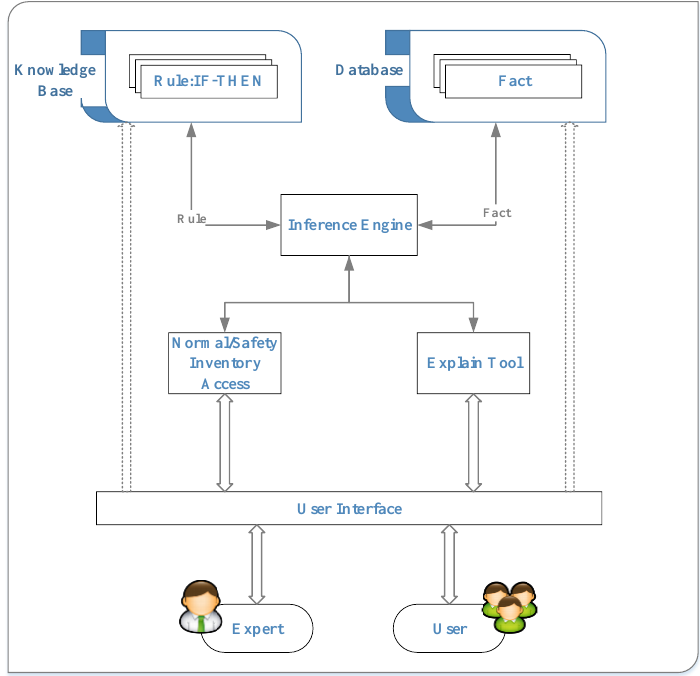
Figure 3. The components and operation processes of the expert system.